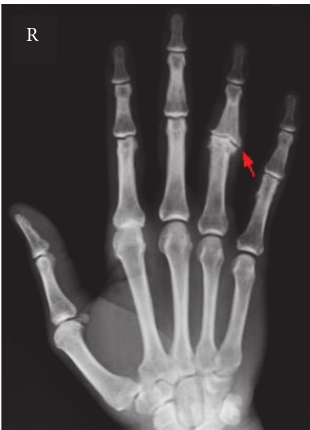
Figure 3: MRI coronal view, edema along